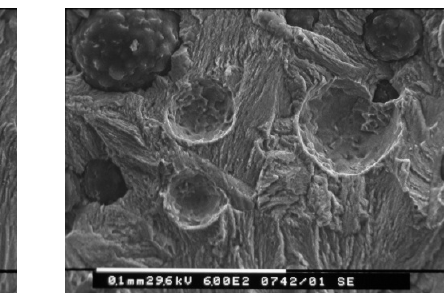
Figure 39: Pearlitic DCI (R = 0.75,  K = 8 MPa √ m).